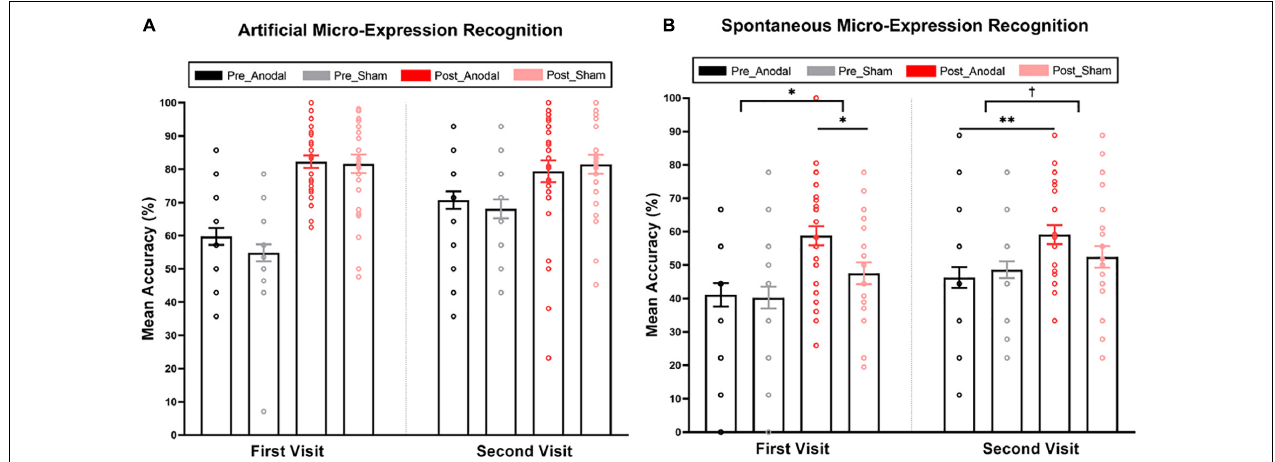
FIGURE 2 | Mean accuracy of artificial and spontaneous micro-expression recognition in pre-test and post-test for the anodal and sham group. (A) Mean accuracy of artificial micro-expression recognition. (B) Mean accuracy of spontaneous micro-expression recognition. The interaction of stimulation and study was significant in the first visit and marginally significant in the second visit. The anodal group performed better than the sham group after training in the first visit. The anodal group rather than the sham group could improve the accuracy of spontaneous micro-expression recognition through training, even if no stimulation was applied in the second visit. Pre_Anodal and Pre_Sham refer to the mean accuracy of the micro-expression recognition in pre-test for the anodal and sham group. Post_Anodal and Post_Sham refer to the mean accuracy of the micro-expression recognition in post-test for the anodal and sham group. The significance levels are marked by different symbols. “ ∗∗ ”, “ ∗ ”, and “ † ” indicate p < 0.01, p < 0.05, and p < 0.1 (two-tailed), respectively. Error bars represent standard error of mean (SEM).